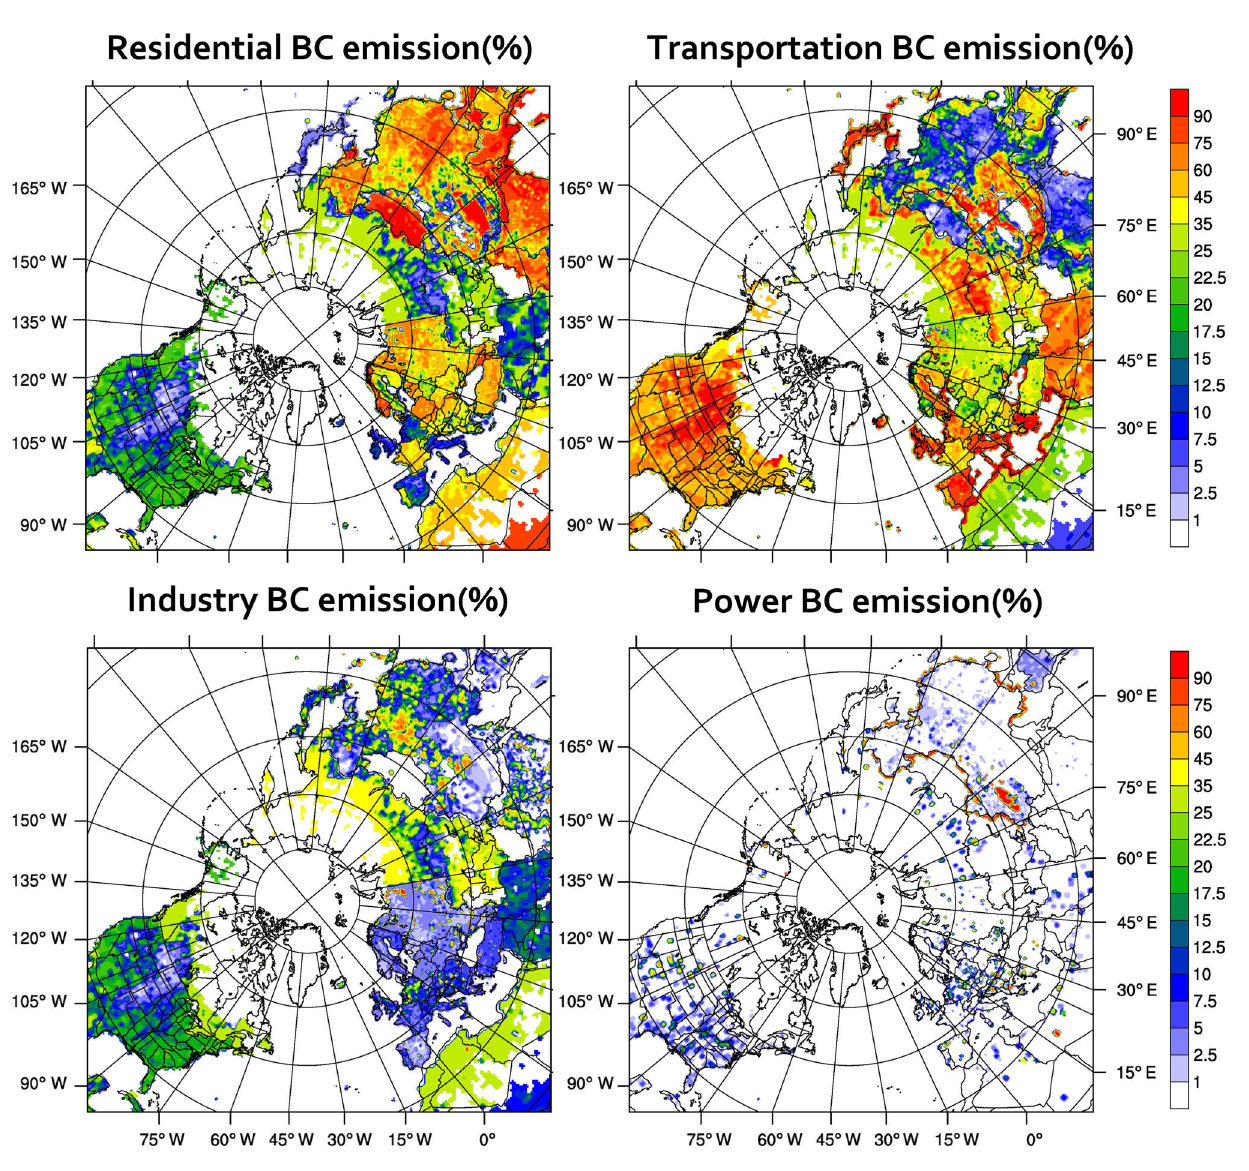
Figure 2. Spatial distribution of economic sectors (%) to total BC anthropogenic emissions on an annual basis. This figure is generated using NCAR Command Language (NCL) version 6.3.0, open-source software free to the public, by UCAR/NCAR/CISL/TDD, http://dx.doi.org/ 10.5065/D6WD3XH5 (last access: 13 November